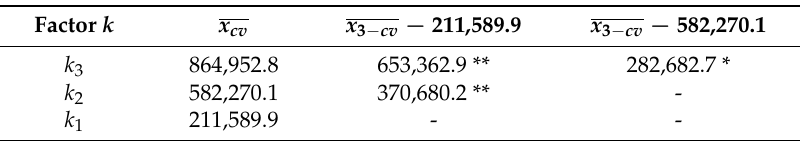
Table 7. Multiple comparison of factor k